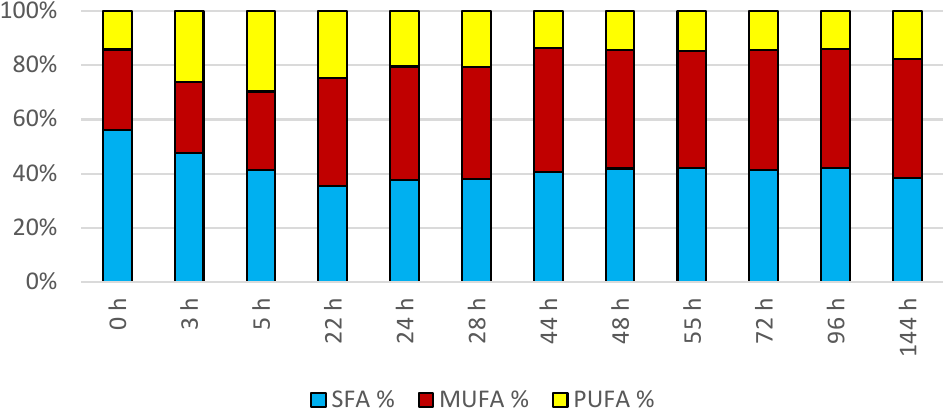
Figure 9. Fatty acid distribution in lipids of yeast strain Rhodotosporidium toruloides in conditions of C/N ratio 25 cultivated in bioreactor.